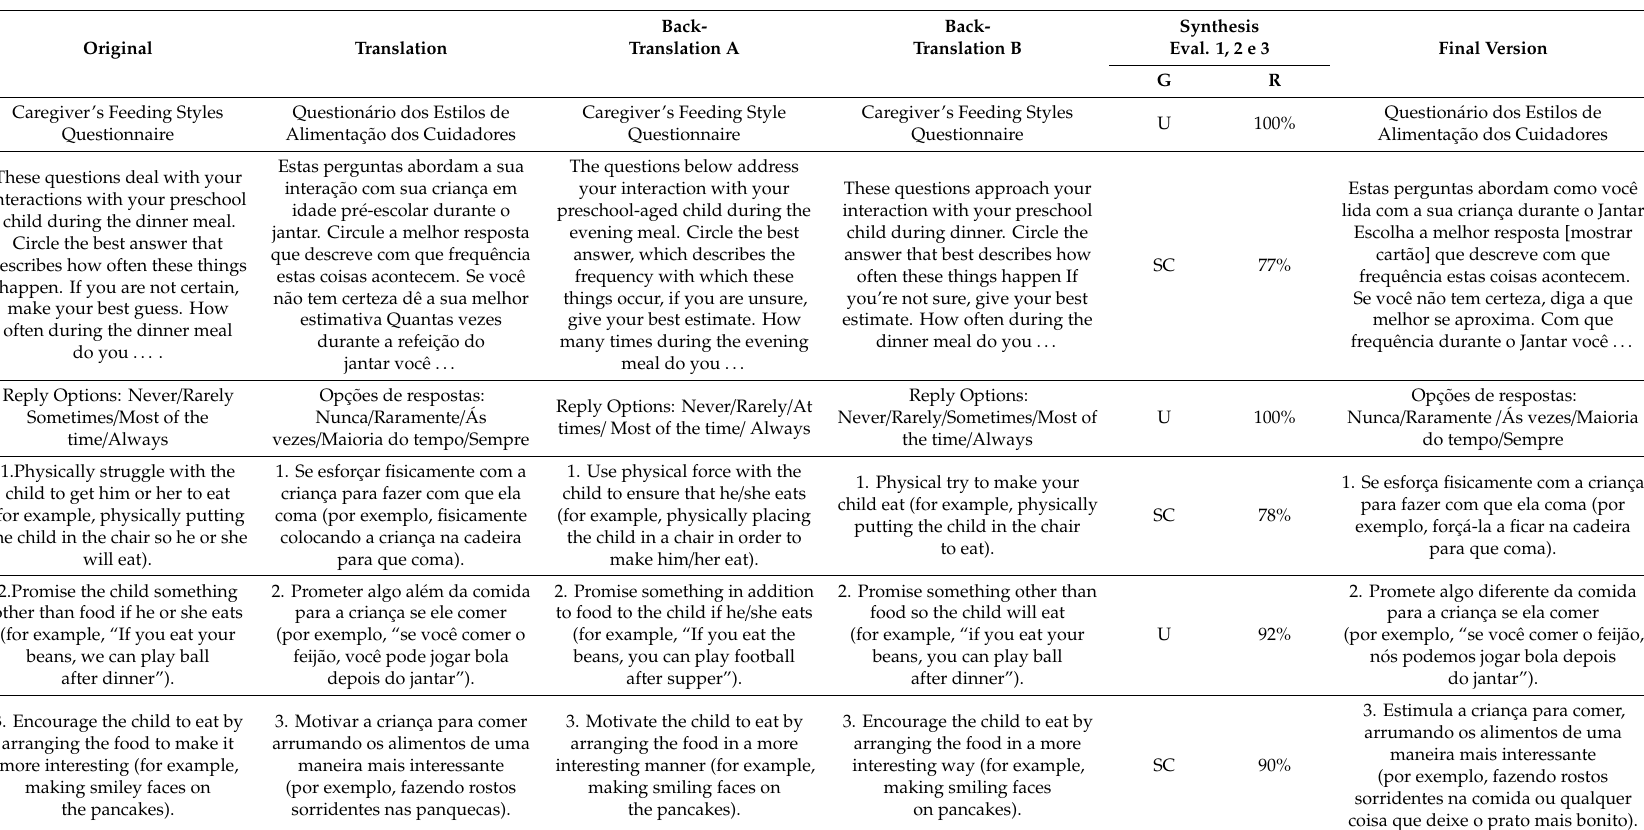
Table 1. Original version, translation, back-translations A and B, Synthesis of General and Referential Semantic Assessment, and the Brazilian final version (Rio de Janeiro) of the Caregiver’s Feeding Styles Questionnaire (CFSQ), Family Health Clinic, Rio de Janeiro, Brazil,